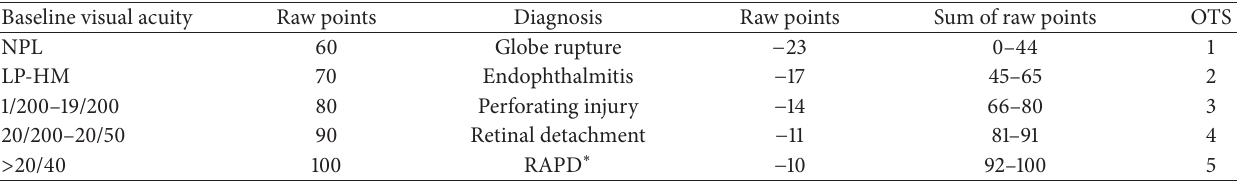
Table 2: The Ocular Trauma Score (OTS). Reproduced from Kuhn et al. [8].